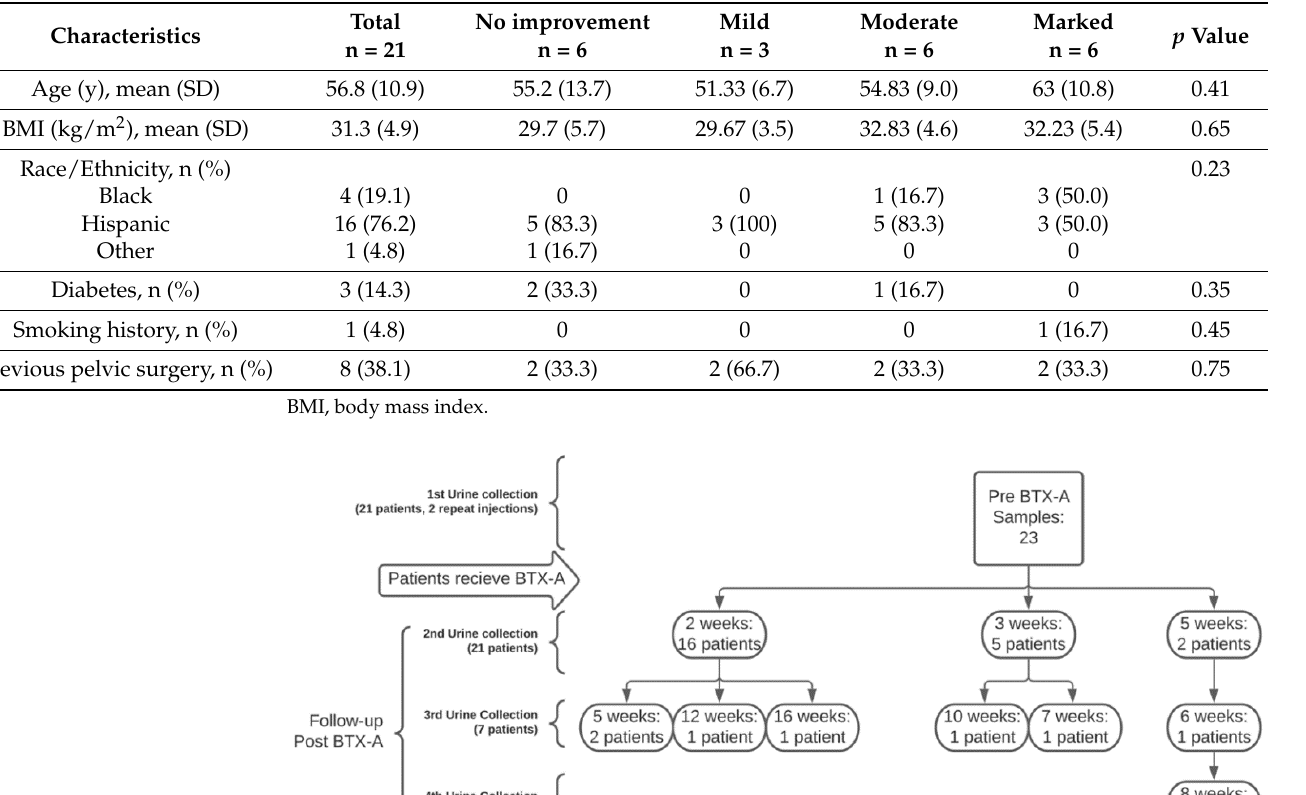
Table 1. Patient Demographics by improvement in OAB-V8 score after intravesical Onabotulinum- toxinA injection.